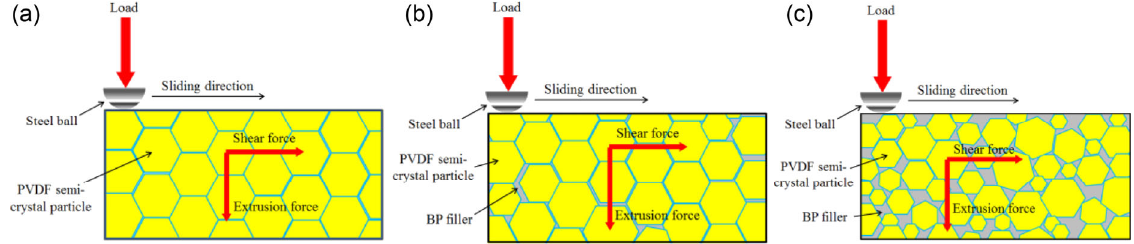
Fig. 34 Schematic diagram of the friction process of composites with different BP contents: (a) neat PVDF; (b) low BP content; (c) high BP